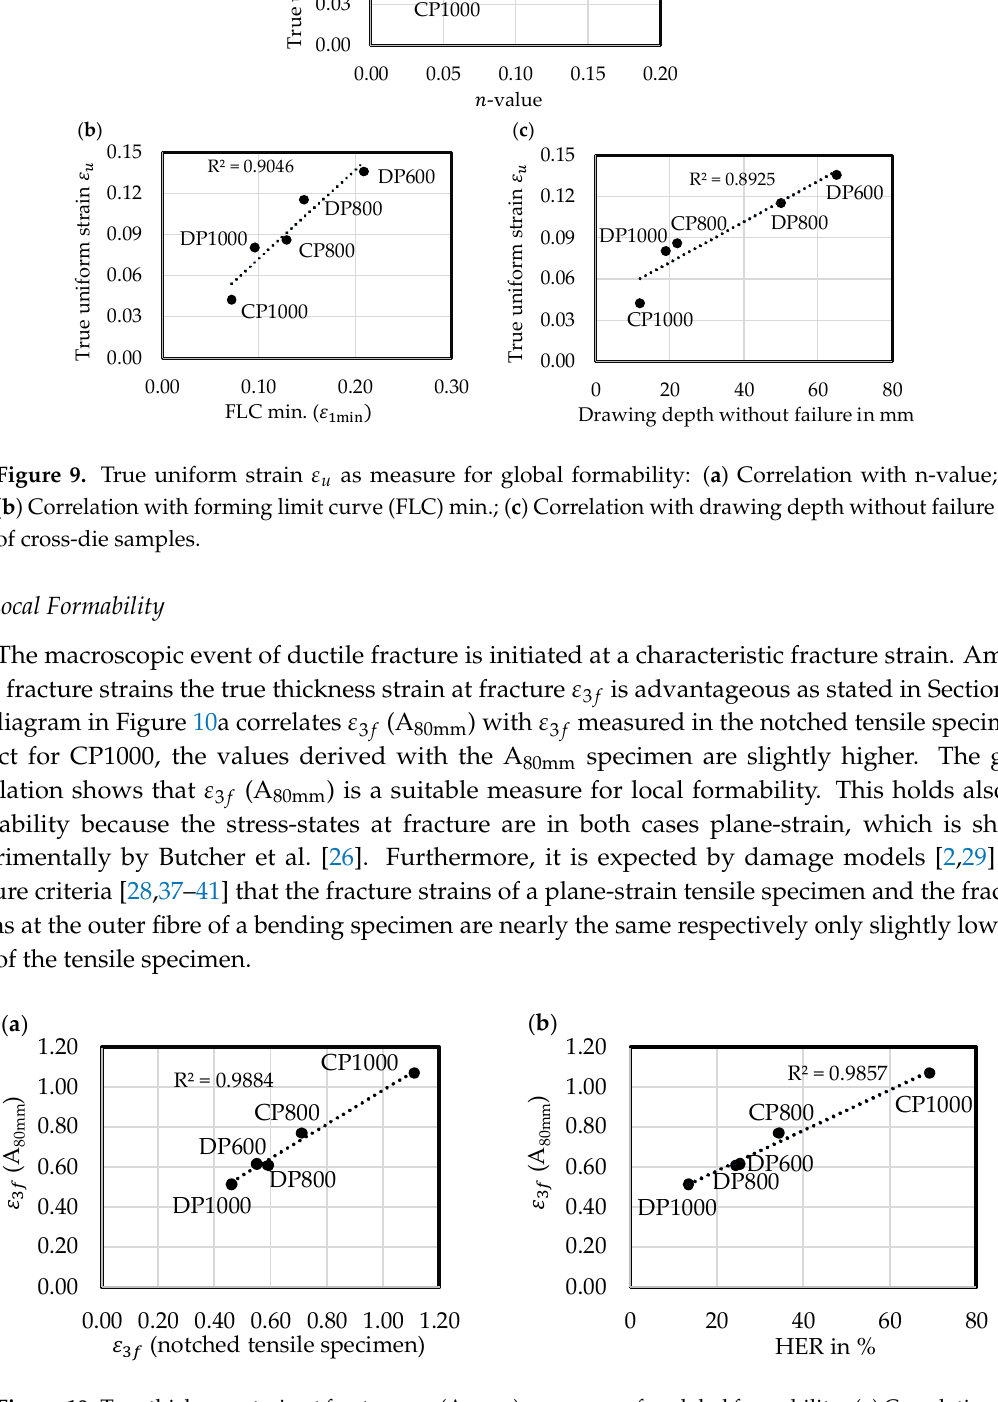
Figure 10. True thickness strain at fracture ε 3 f (A 80mm ) as measure for global formability: ( a ) Correlation with ε 3 f (notched tensile specimen); ( b ) Correlation with hole expansion ratio (HER).